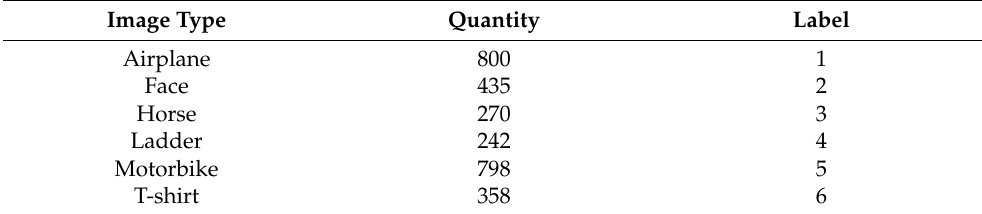
Table 1. Types, quantities, and labels of